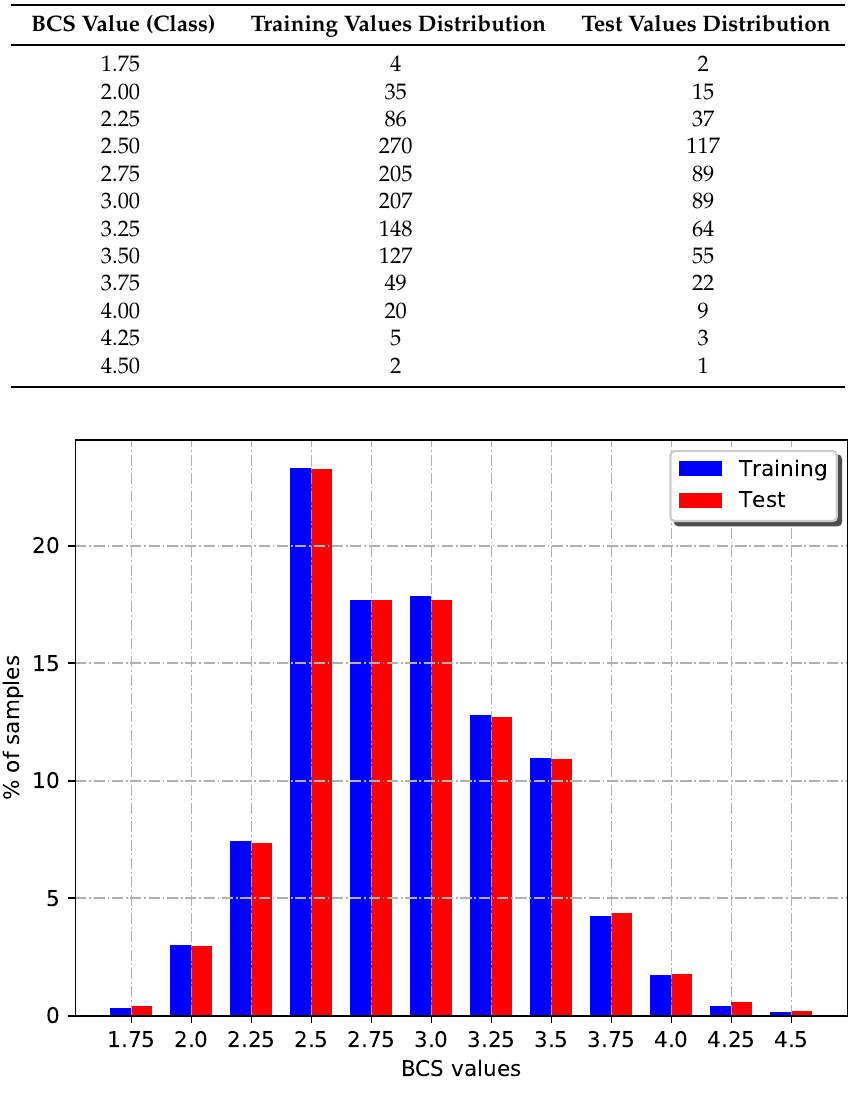
Figure 2. Percentage of BCS values distribution over training and test